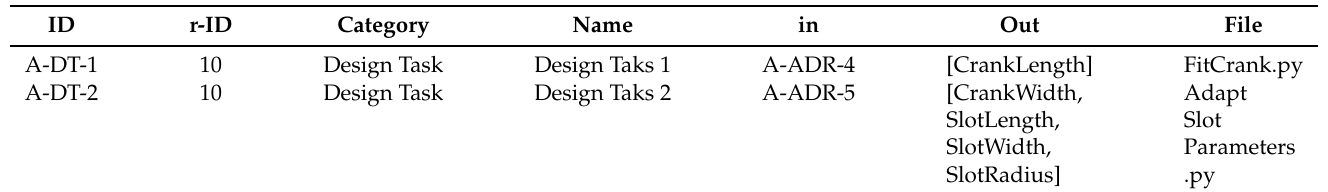
Table A4. Annotated Design Tasks for the bike crank use case.